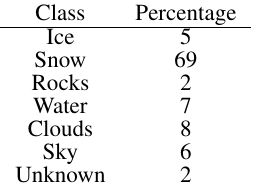
Table 1. Class distribution of all training images used to train the